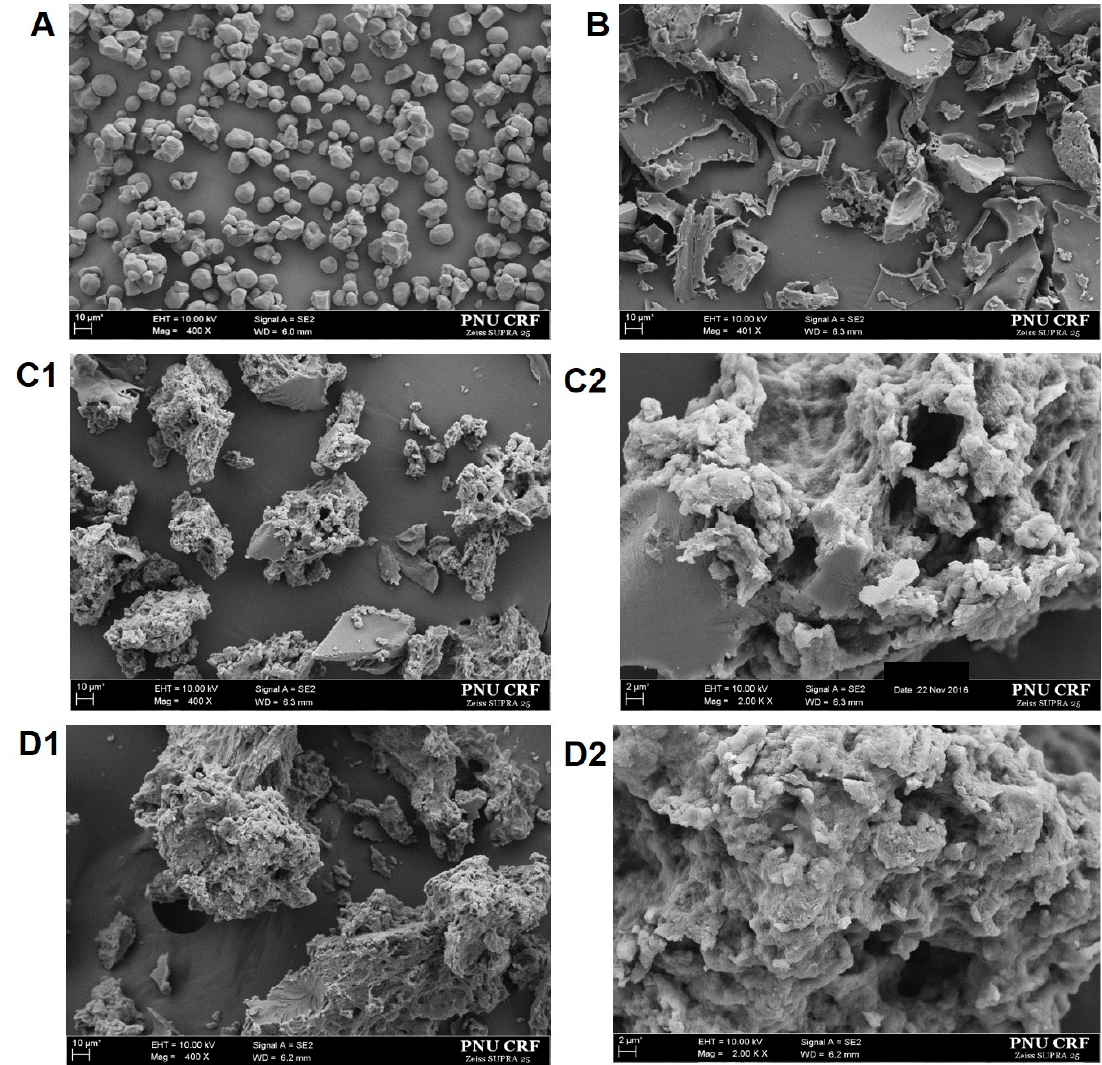
Figure 1. Field-emission scanning electron microscope images of ( A ) native waxy corn starch, ( B ) control starch, ( C1 , C2 ) 230 U-AS-treated starch, and ( D1 , D2 ) 460 U-AS-treated starch. Magnifications: ( A , B , C1 , D1 ), ×400, and ( C2 , D2 ), ×2000.